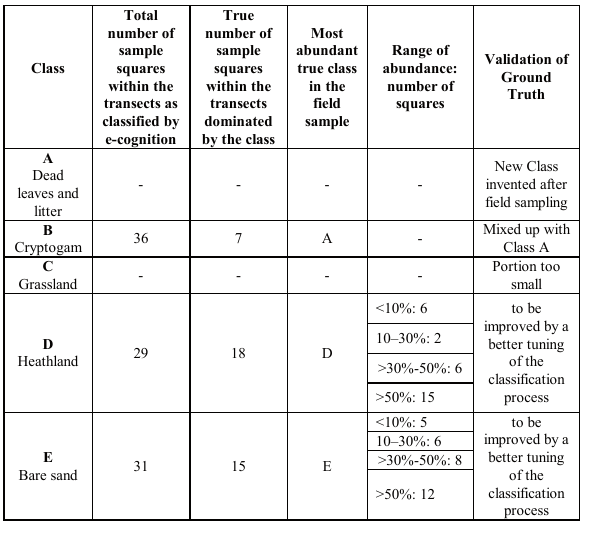
Table 3. On-screen accuracy Assessment of the Westruper Heide test site